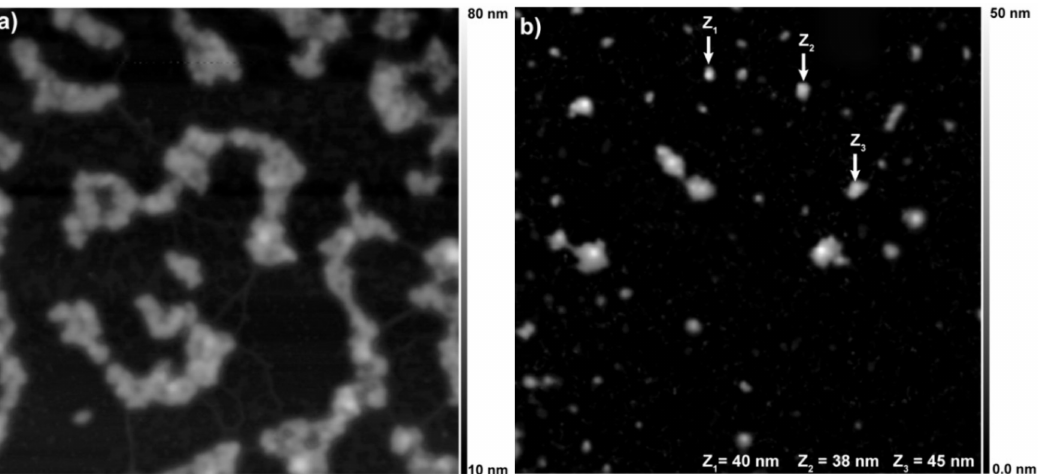
Figure 3. Atomic force microscopy of the PLGA-CDs1% ( a ) and PLGA-CDs20% ( b ) nanoparticles. Z represents the height of the nanoparticles. Observed field, 16 µ m 2 (4 × 4 µ